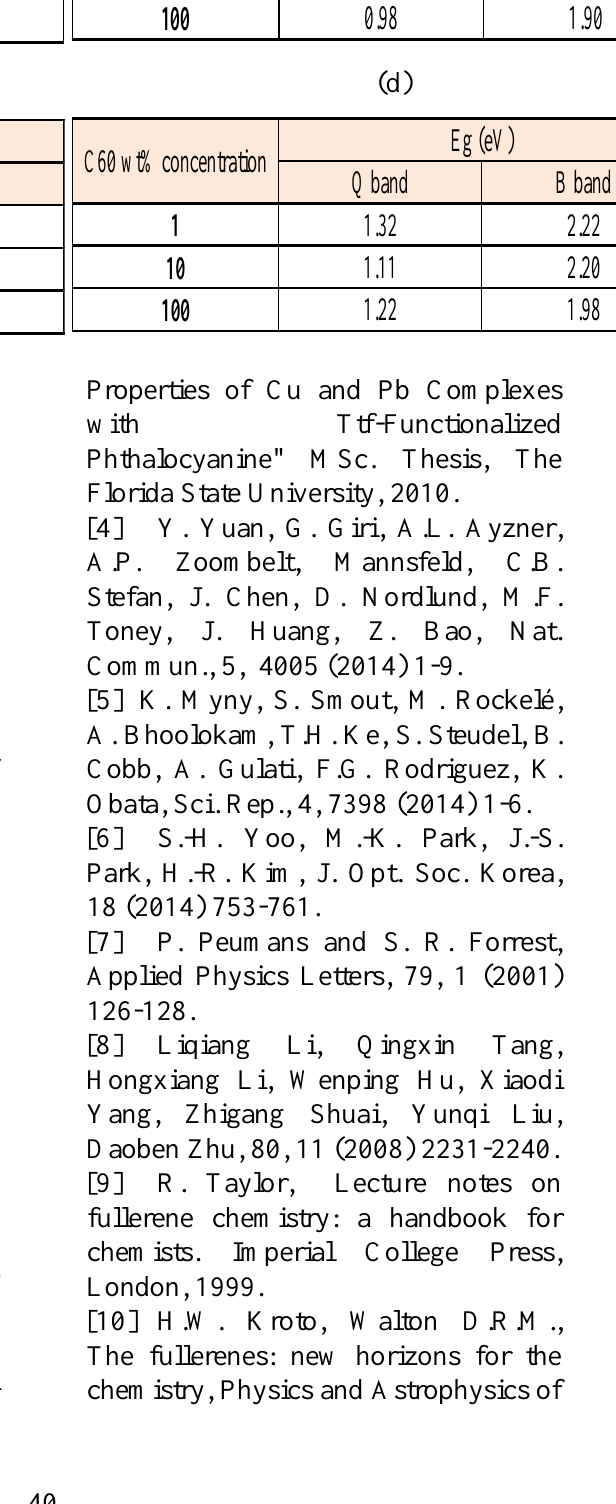
) thin films with different C 60